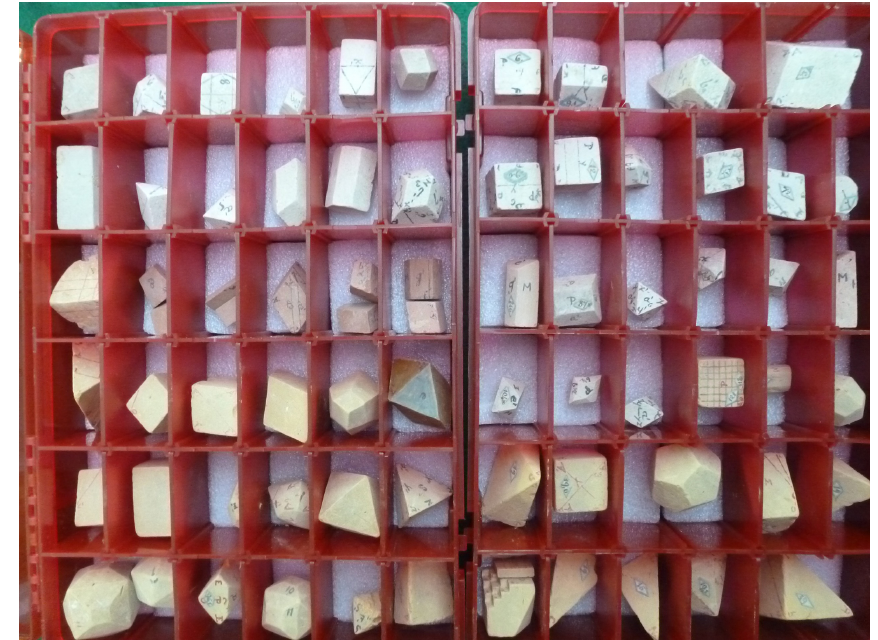
Figure 2. Terracotta models. Dimensions of models max